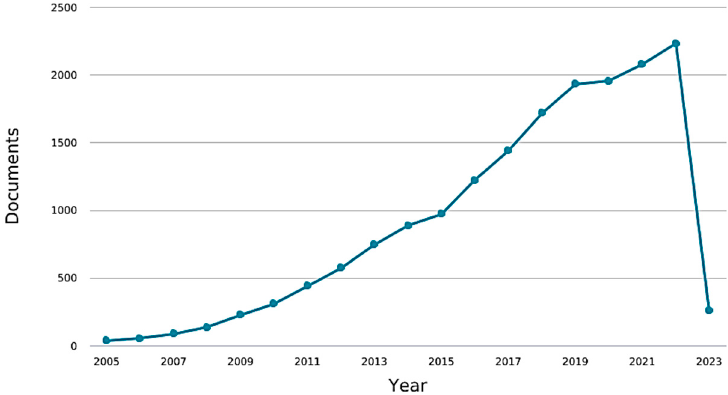
significant decrease.